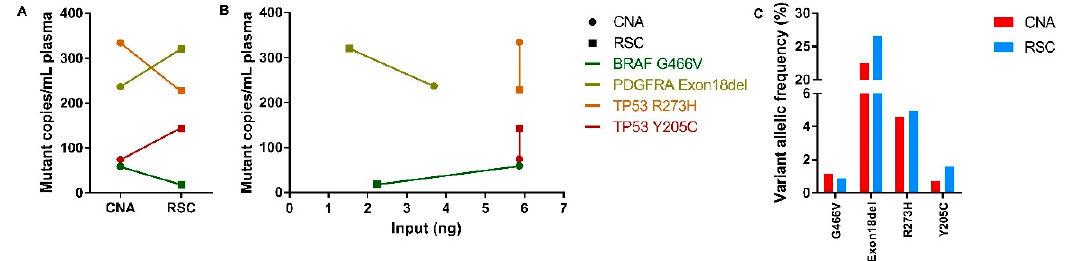
Figure 3. Mutation detection in ccfDNA extracted from plasma with the QIAamp Circulating Nucleic Acid (CNA) and Maxwell RSC ccfDNA Plasma (RSC) methods. ( A ) Before-after plot illustrating the number of mutant copies per mL of plasma for four paired CNA-extracted (dots) and RSC-extracted (squares) samples. ( B ) XY plot illustrating the detected mutant copies per mL of plasma plotted against the input in ng on the x-axis. Similarly colored results originate from the same patient harboring a detectable mutation according to the legend. ( C ) Bar graph illustrating the detected higher variant allelic frequency (VAF) in a percentage of four paired CNA-extracted (red) and RSC-extracted (blue) samples.